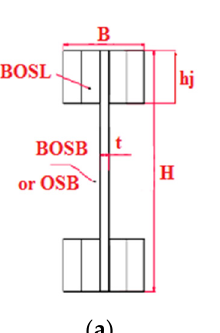
Figure 1. Details of I-beam: ( a ) I-beam cross section; ( b ) side and front view of the inner BOSL con- nection type in B400GN; ( c ) side and front view of the outer BOSL connection type in B400GN.